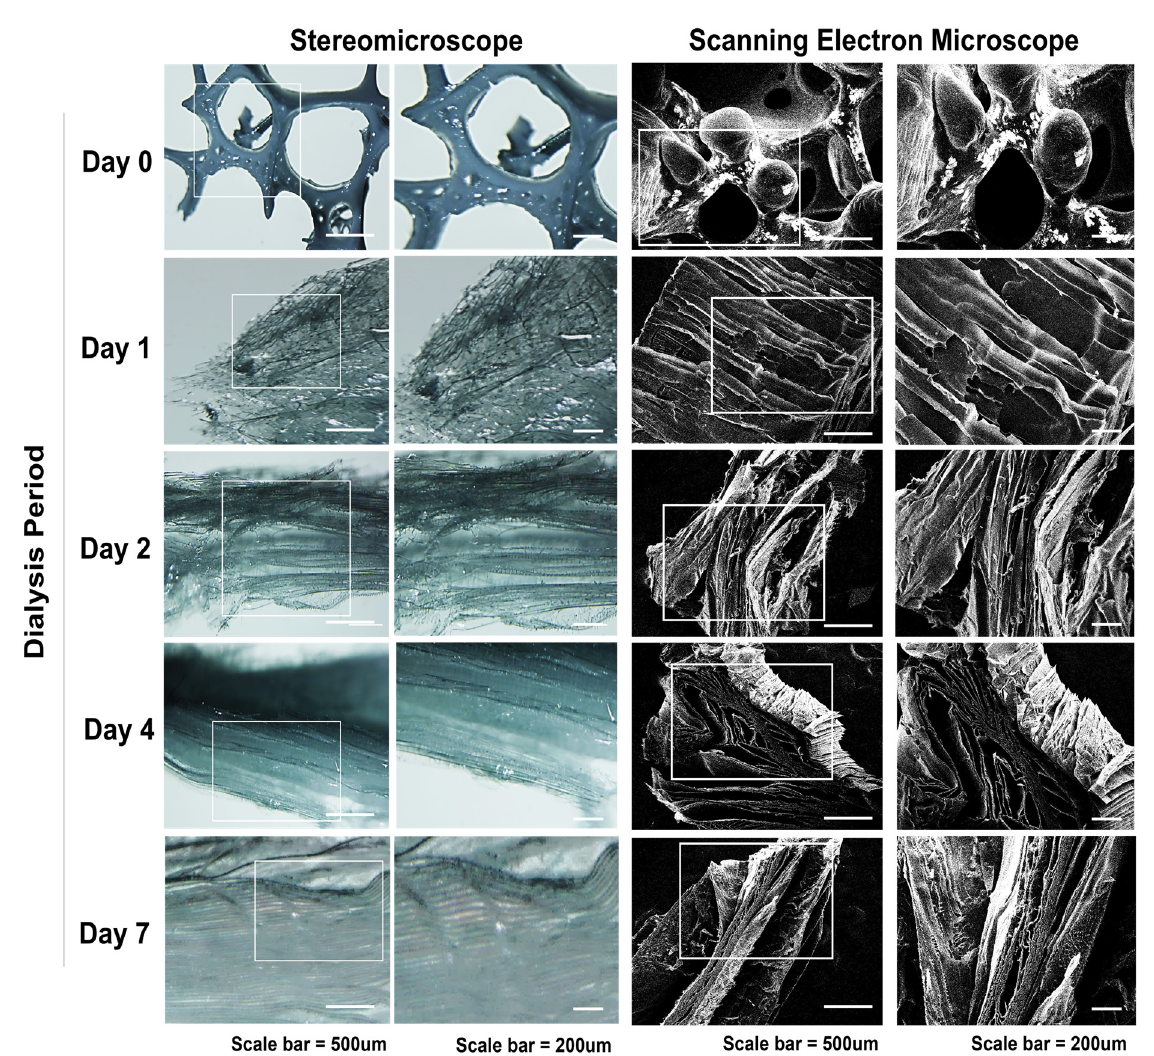
Figure 4. Stereomicroscopic and scanning electron microscopic (SEM) findings. Freeze-dried Silk-GMA samples from each dialysis period were demonstrated for the analysis with stereomicroscope and SEM. The uneven structures were shown on dialysis day 0; however, interconnected regular sheeted-shape microstructures were detected increasingly following dialysis periods on days 1, 2, 4, and 7. Scale bar showed 500 µ M and 200 µ M, separately.